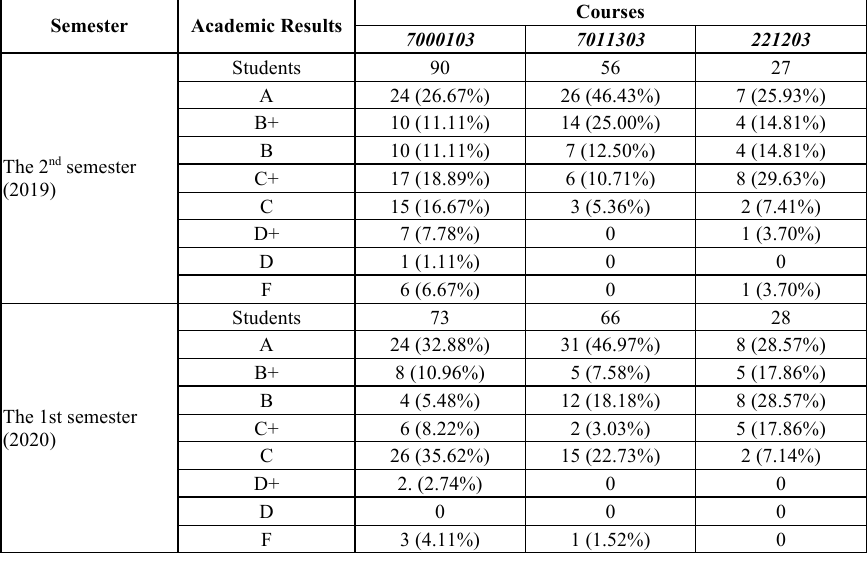
Table 9. Comparison of the two